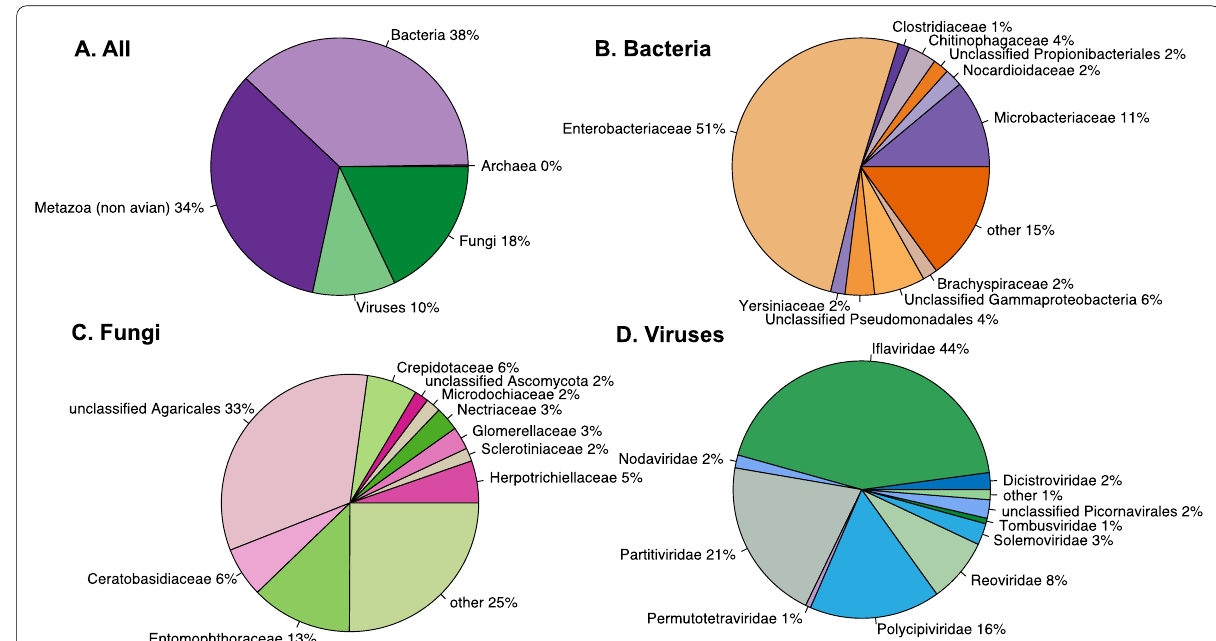
Fig. 1 Pie charts detailing the toutouwai cloacal infectome. The size of each slice represents the relative abundance of the group in question. A The proportion of RNA contigs with hits to non-avian metazoan species, bacteria, viruses and fungi, following removal of avian hits. B-D The proportion of RNA with hits to the ten most abundant bacteria, fungi and virus families. The remaining families are grouped into ‘other’. The percentage of the total abundance (the sum of all pools) is shown, rounded to the nearest whole